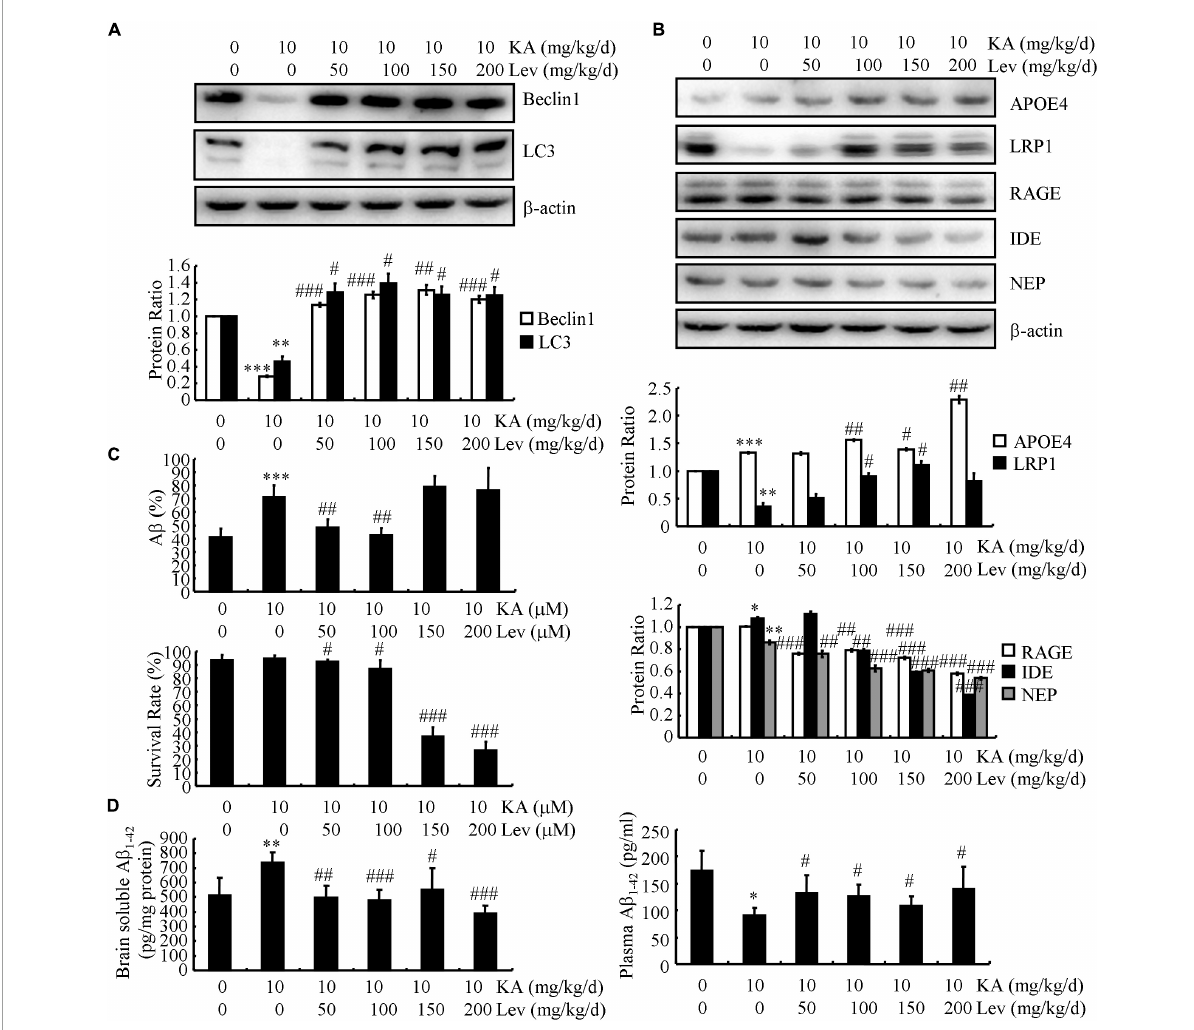
FIGURE3 LEV treatment promotes the clearance of A β in KA-stimulated APP23/MAPT mice. (A,B) Protein levels of Beclin1, LC3, APOE, LRP1, RAGE, IDE, and NEP in the brains of KA (10 mg/kg/d)- or LEV (50, 100, 150, or 200 mg/kg/d) + KA-treated APP23/MAPT mice. (C) Mouse neuroblastoma cell line N2a cells are treated with hA β (10 ng/mL) for 24 h; after incubation with KA and LEV (50, 100, 150, or 200 M), the remaining hA β -treated cells were assessed using enzyme-linked immunosorbent assay and the survival rate was calculated using the MTT assay. (D) hA β (3 µ g) was intracerebroventricularly injected into the mice; after 24 h, the levels of hA β in the brain and plasma of APP23/MAPT mice were determined using enzyme-linked immunosorbent assay ( ∗ P < 0.05; ∗∗ P < 0.01; ∗∗∗ P < 0.001 vs. the control group; # P < 0.05; ## P < 0.01; ### P < 0.001 vs. the KA-treated group, Student’s t -test). KA, kainic acid; LEV, levetiracetam; A β , amyloid β -peptide; h,